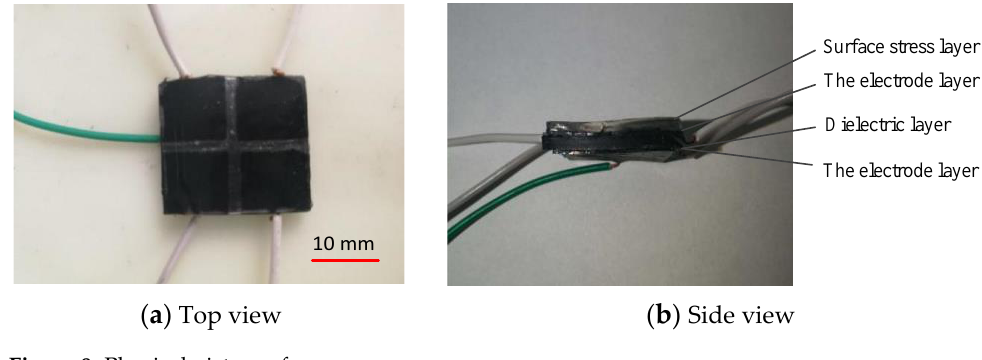
Figure 8. Physical picture of sensor.